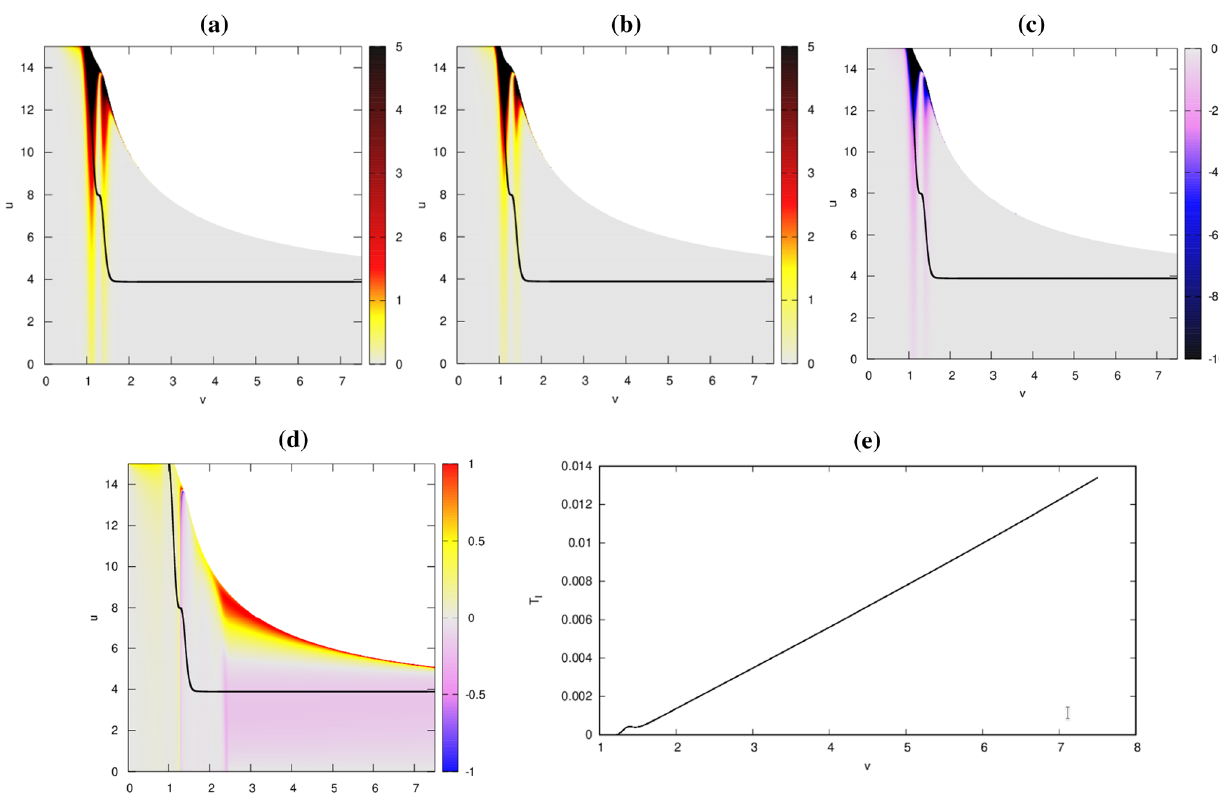
Fig. 9 The (v u ) -distribution of a energy density, ˆ ρ , b radial pressure, ˆ p ˆ p r , c pressure anisotropy, a , d tangential to radial pressures ratio, and e local temperature along the black hole apparent horizon, T l , as